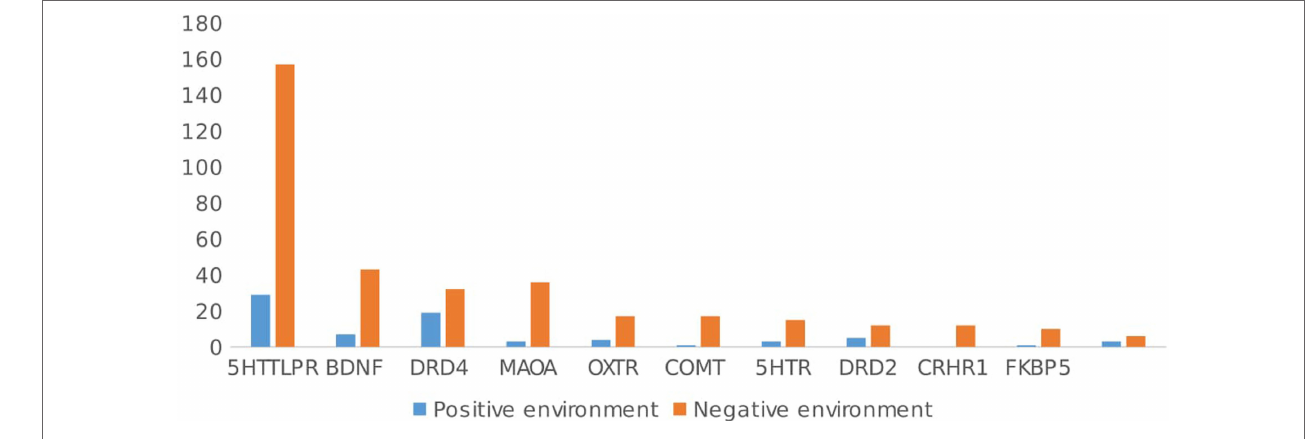
FiGURe 4 | Type of environment studied ( negative vs. positive ) by